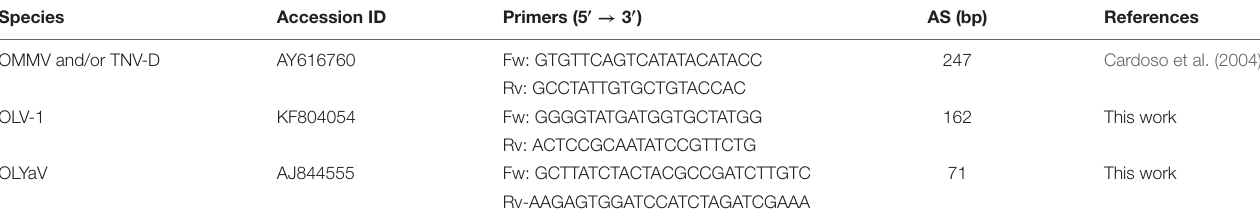
TABLE 2 | Primers used on qPCR assays.